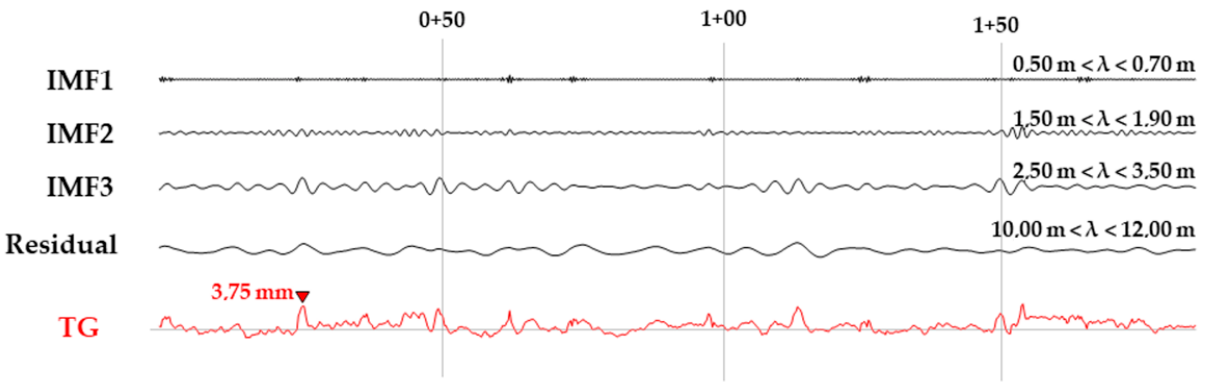
Figure 14. Illustration of the IMF components of TG calculated by VMD (X-axis represents distance along the track in [m] unit, while Y-axis represents ALL in [mm] unit).